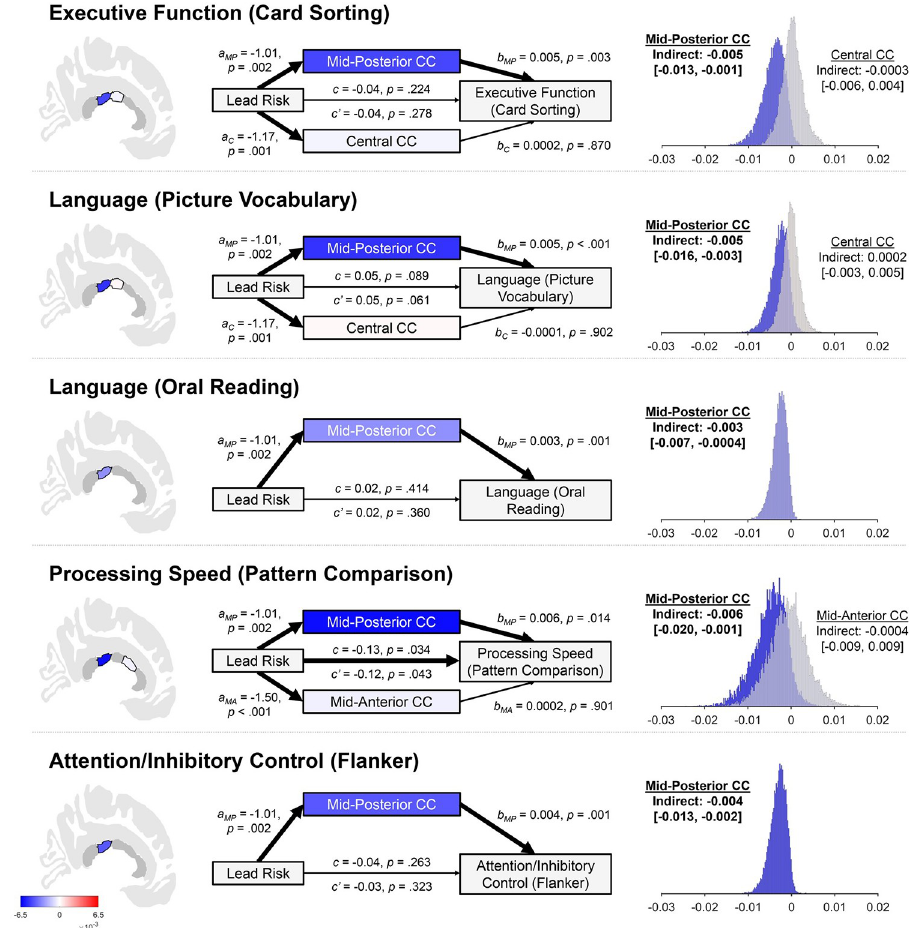
Fig 4. Mediational analyses showing indirect associations of lead risk on cognitive performance through mid- posterior corpus callosal (CC) volume. The title of each row [e.g., “Executive Function (Card Sorting)”] refers to the construct and task used to assess that construct. The shading of the callosal regions, the mediator boxes (e.g., Mid- Posterior CC, Central CC), and histograms reflect the strength of the indirect association (per the color bar in the lower left corner). Callosal regions in dark gray were not incorporated as mediators in the corresponding analysis. Total effects of lead risk are represented by c , direct effects of lead risk are represented by c’ , and a and b values refer to the associations of lead risk on callosal volume and callosal volume on cognitive performance, respectively. The subscript of the a and b values refer to the callosal subregion (i.e., C = central, MA = mid-anterior, MP = mid- posterior). All a , b , c , and c’ values are unstandardized regression coefficients. Thick arrows designate significant associations. Thin arrows designate non-significant associations. The presence of the statistical significance of indirect associations was determined by construction of bias-corrected percentile bootstrapping 95% confidence intervals (i.e., 10,000 bootstrapped samples), irrespective of the statistical significance of the corresponding total effect. The distributions of these bootstrapped indirect associations are shown, along with the original-sample indirect associations and corresponding confidence intervals. Bolded font indicates statistically significant indirect associations. Age, sex, parental education, race, ethnicity, and family income were included as covariates in analyses. Card Sorting = Dimensional Change Card Sort Task. Picture Vocabulary = Picture Vocabulary Test. Oral Reading = Oral Reading Recognition Test. Pattern Comparison = Pattern Comparison Processing Speed Test. Flanker = Flanker Inhibitory Control and Attention Test. volumes of the callosal body in 8- to 12-year-olds (mid-anterior + central + mid-posterior) [70]. Posterior corpus callosal size was 3.1% (7.9%) smaller in 12- to 18-year-old males (females) prenatally exposed to cigarette smoking [71], and splenial (posterior corpus callosal) size in 4.5-year-olds was 1.4% smaller given high versus low levels of prenatal polychlorinated-